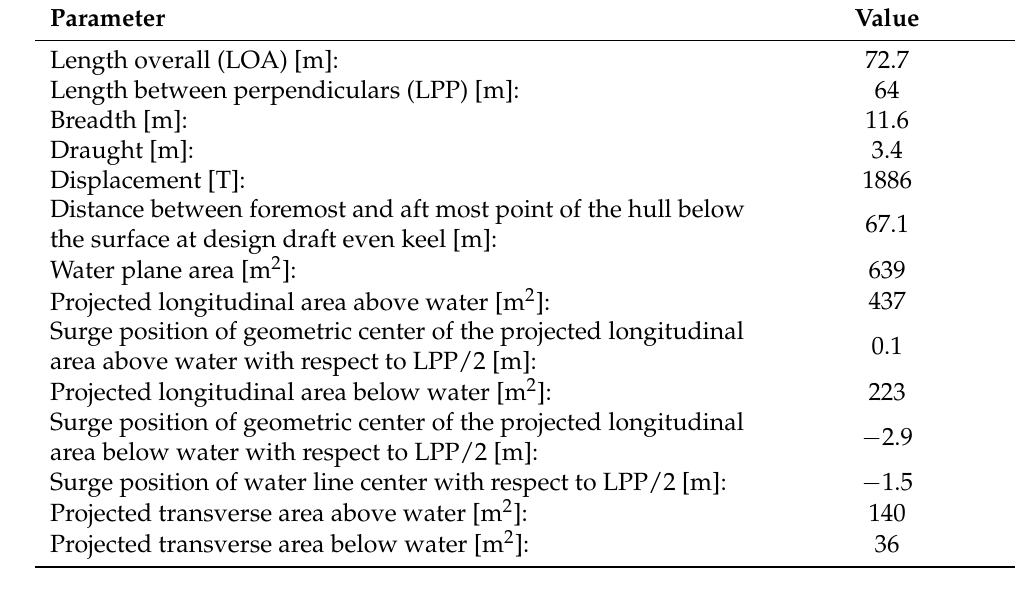
Table 6. Ship hull data for anchor positioning system.